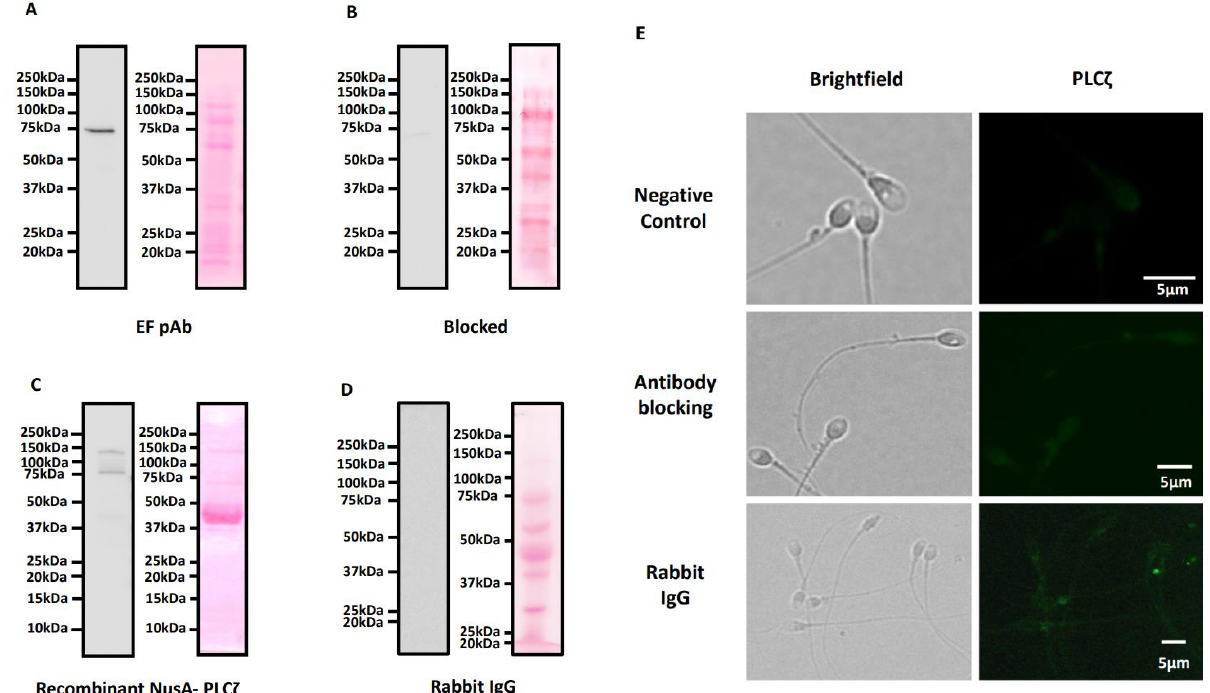
Figure 1. Immunoblotting analysis and corresponding ponceau-stained images indicating the specificity of the EF polyclonal antibody in recognising PLC ζ in human sperm. The EF pAb recognised a single band at the expected molecular weight for human sperm and recombinant PLC ζ (~70 kDa) ( A , C ). This band was depleted following blocking with recombinant NusA-PLC ζ protein (~150 kDa) ( B ). Immunoblotting with rabbit IgG did not identify any protein bands ( D ). ( E ) Representative images of secondary antibody incubation only, without a primary antibody: top panel, negative control, and antibodies blocked with a molar excess of purified recombinant NusA-PLC ζ ; middle panel, antibody blocking, and sperm treated with rabbit IgG as primary antibody treatment; bottom panel, rabbit IgG. Brightfield (left panels) and PLC ζ (green fluorescence, left panels) images were obtained. Both panels indicated diminished/absent levels of PLCζ fluorescence. Representative images obtained were captured at 100 × and white scale bars represent 5 µ m. Images are representative of 100 cells examined for each